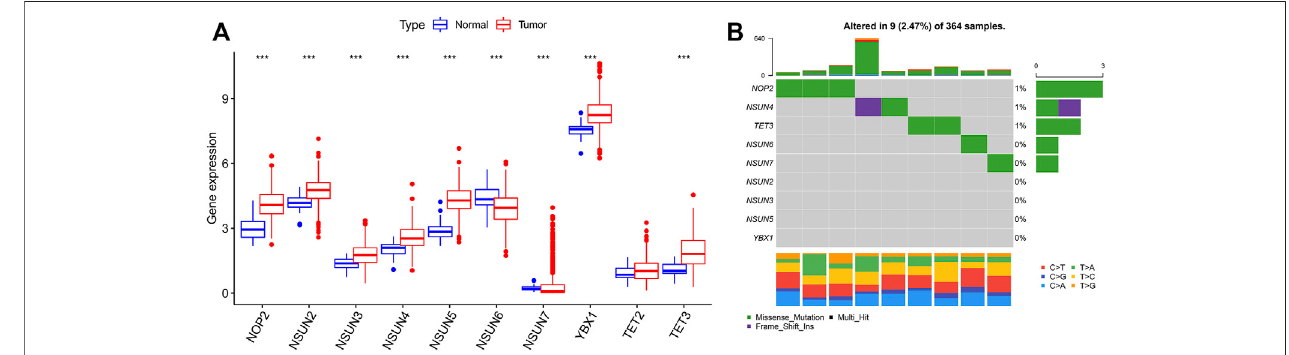
FIGURE 1 | 5C modi fi cation pattern in HCC. (A) The expression of m5C regulators in tumor and normal tissues; (B) The mutation frequency of m5C regulators in HCC (Each column represents a patient with a m5C regulator mutation, and the upper panel shows the tumor mutation burden. 0 – 3 means the number of patients with mutation, and 0 – 640 means the total mutation frequency of each patient).